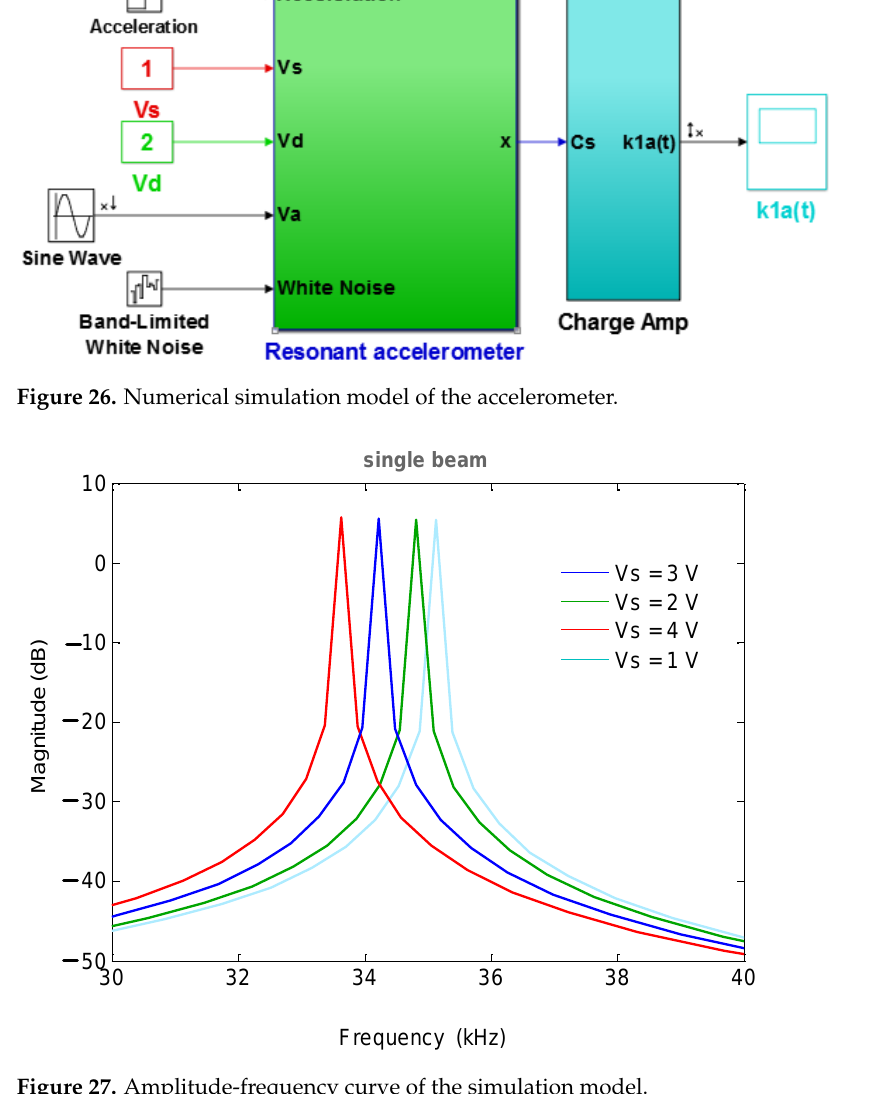
Figure 27. Amplitude-frequency curve of the simulation model.